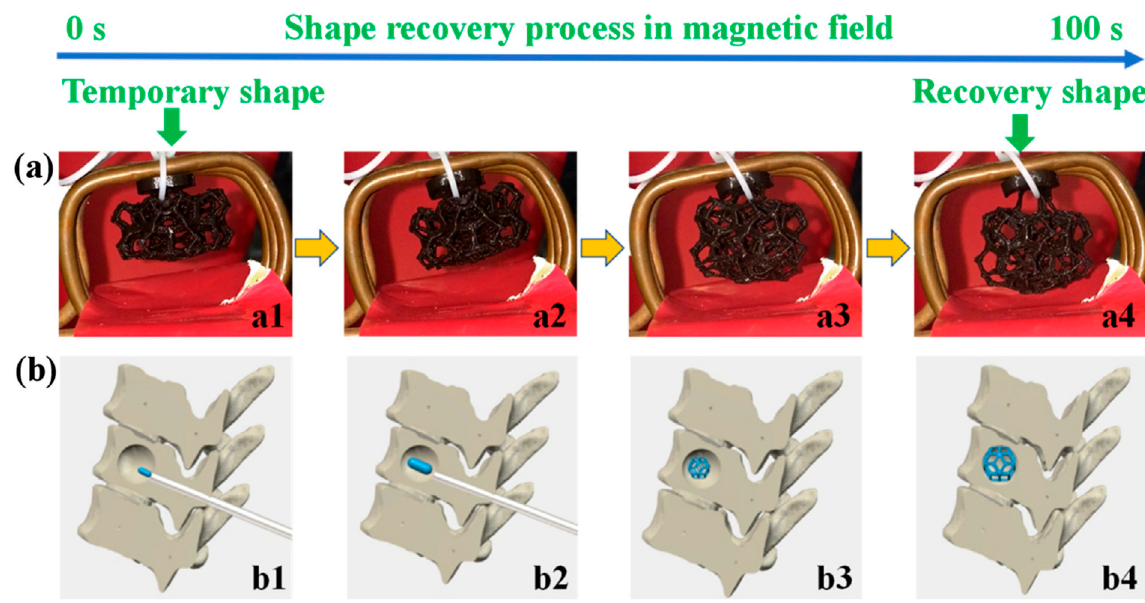
Figure 6. The shape recovery of a printed structure (above ( a1 – a4 )), the simulation of the shape recovery of a bone support structure in a bone (below, ( b1 – b4 )) [13].